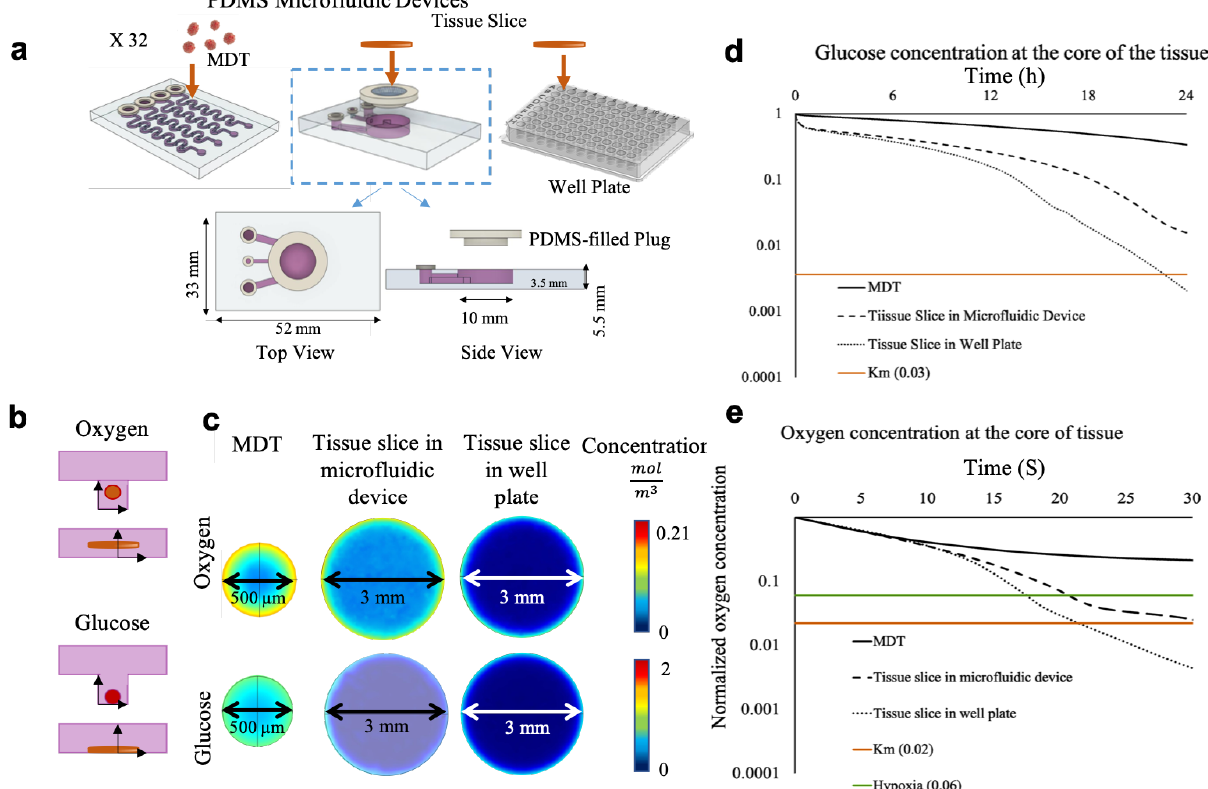
Figure 1. Design and operation of the microfluidic devices. ( a ) Schematic representation of the culture vessels. ( b ) Schematic representation of tissue positioning for worst case scenario for oxygen (top) and glucose (bottom). ( c ) Finite element simulation of the concentration distribution of glucose (at 24 h post-culture) and oxygen (at 30 s) in the midplanes of tumor models. Simulated changes in the concentration of glucose ( d ) and oxygen ( e ) in culture .